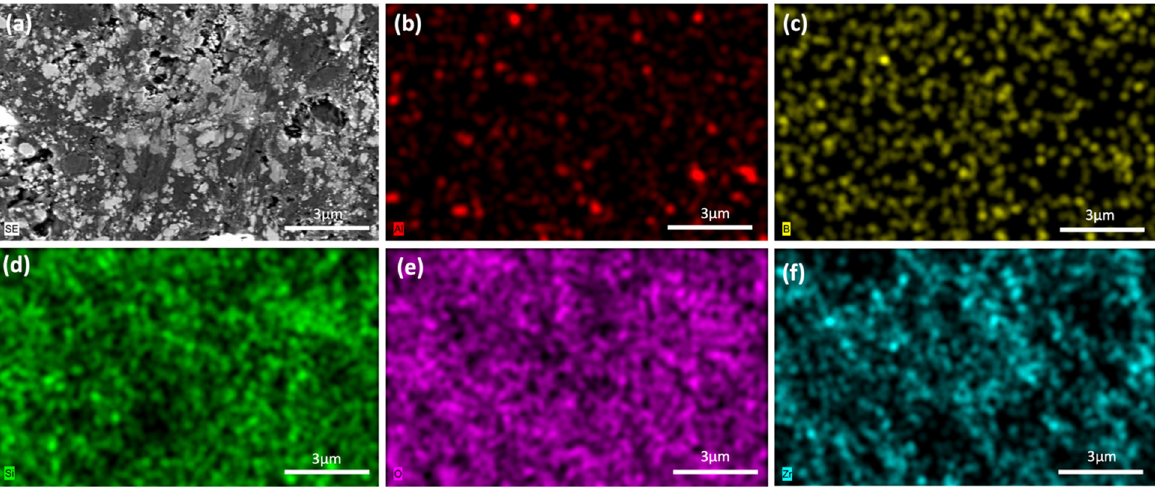
Figure 8. SEM/EDX analyses of the 40Zr-Ar sample: ( a ) SEM image, ( b ) EDX mapping of Al, ( c ) EDX mapping of B, ( d ) EDX mapping of Si, ( e ) EDX mapping of O, and ( f ) EDX mapping of Zr .